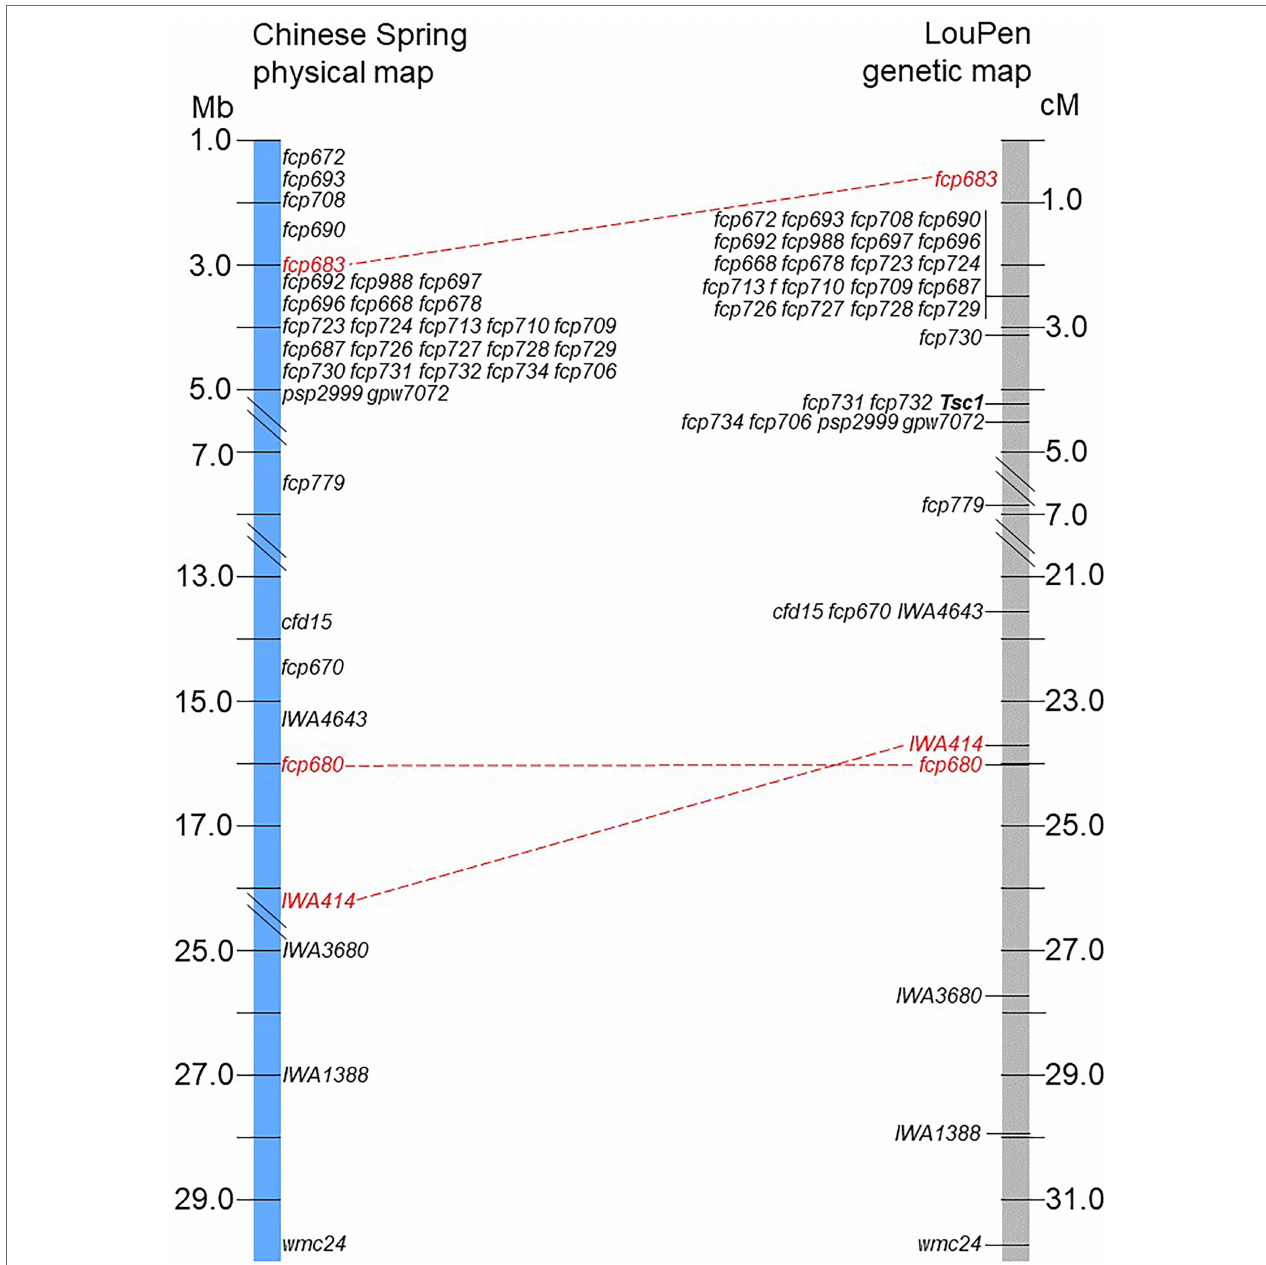
FIGURE 3 | Comparison of the physical and genetic order of markers. The LouPen genetic map is on the right and the Chinese Spring v2.1 physical map is on the left. Markers in red font connected by red dashed lines are not colinear. All other markers are